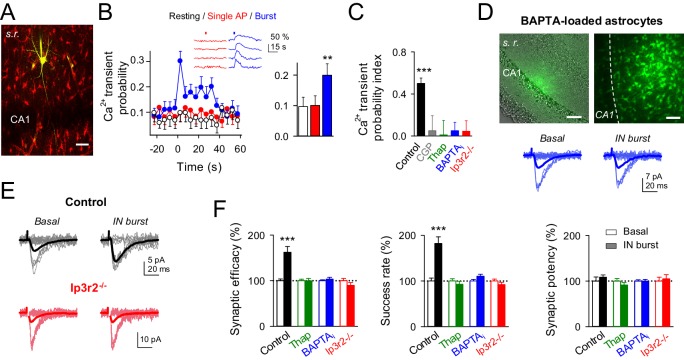
Interneuron-induced synaptic potentiation requires astrocyte Ca2+ elevations.(A) Image of recorded interneuron (yellow) and SR101-labelled astrocytes (red) in CA1 region. Scale bar, 40 µm. (B) Left, astrocyte Ca2+ transient probability over time (zero time corresponds to interneuron depolarization) in resting conditions (white), and after evoking single (red) or bursts (blue) of interneuron APs, and somatic Ca2+ signals from four representative astrocytes in the field of view to single APs (red) and burst of interneuron APs (blue). Red and blue bars denote interneuron stimulation. Right, average values for those conditions. Single APs (red; p=0.92; paired t test), burst of interneuron APs (blue; p=0.007; 58 astrocytes, nine slices). (C) Ca2+ transient probability index after bursts of interneuron APs in control (58 astrocytes, nine slices; p<0.001; Wilcoxon rank-sum test), CGP55845 (91 astrocytes, 10 slices; p=0.824; Wilcoxon rank-sum test), thapsigargin (41 astrocytes, five slices; p=0.37; Wilcoxon rank-sum test), BAPTA-loaded astrocytes (41 astrocytes, nine slices; p=0.2622; Wilcoxon rank-sum test), and Ip3r2-/- mice (112 astrocytes, 14 slices; p=0.4319; Wilcoxon rank-sum test). (D) Left, merge DIC and fluorescence image of the CA1 pyramidal layer and stratum radiatum (s.r.) showing the location of the biocytin-filled astrocyte network (green). Right, maximal projection confocal image of the astrocytic syncytium revealed by biocytin-loading via whole-cell astrocyte recording, showing the distribution of biocytin-coupled astrocytes. Scale bars, 50 µm. Bottom, synaptic responses evoked by minimal stimulation (15 consecutive stimuli; light traces), and averaged EPSCs (50 consecutive stimuli; dark traces) before and after interneuron AP bursts in BAPTA-loaded astrocytes (blue). (E) Synaptic responses evoked by minimal stimulation (15 consecutive stimuli; light traces), and averaged EPSCs (50 consecutive stimuli; dark traces) before and after interneuron AP bursts in control (black) and Ip3r2-/- mice (red). (F) Relative changes of synaptic parameters induced by bursts of interneuron APs (filled bars), in control (n = 6; p<0.001; paired t test), thapsigargin (n = 9), BAPTA-loaded astrocytes (n = 11), and Ip3r2-/- mice (n = 8). See also Figure 3—figure supplement 1. **p<0.01, ***p<0.001; paired t test.